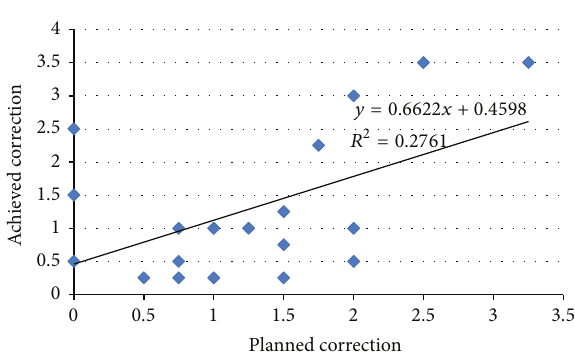
Figure 3: Gain/loss of lines of CDVA.